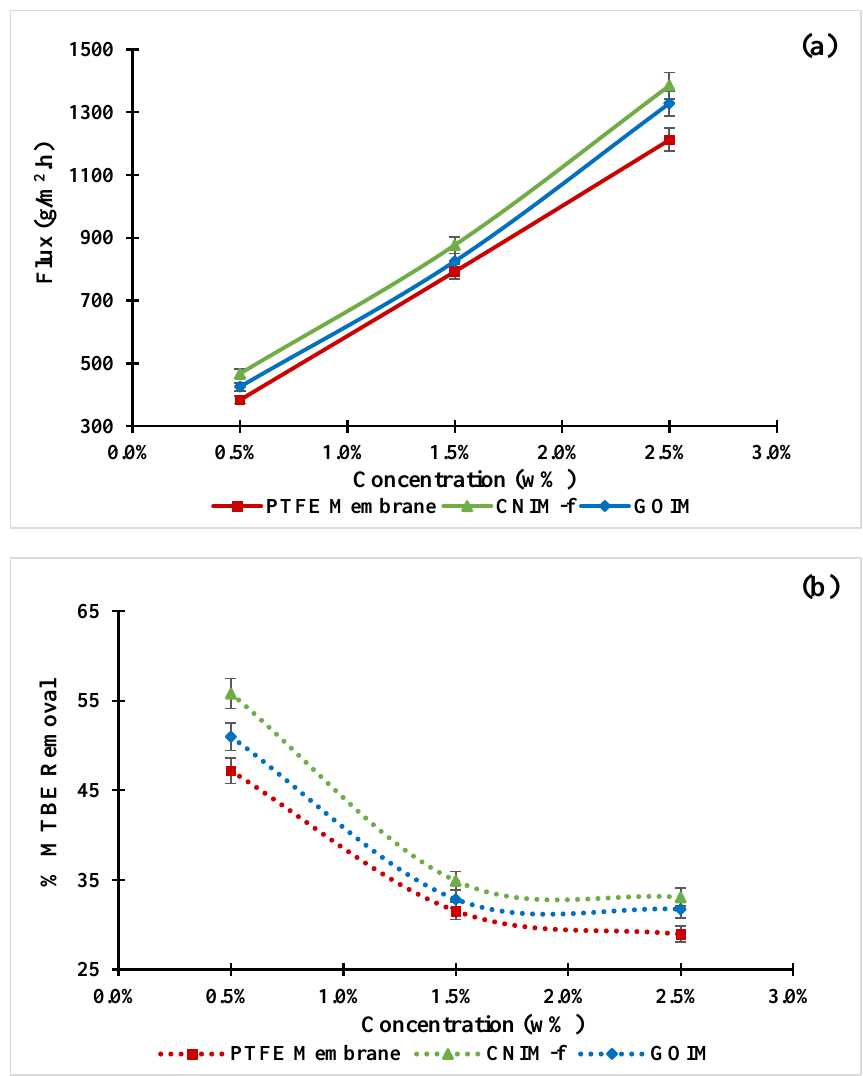
Figure 6. ( a ) Effect of feed concentration on MTBE flux, and ( b ) % MTBE removal as the function of feed concentration at the feed temperature of 30 °C and the feed flow rate of 20 mL/min.